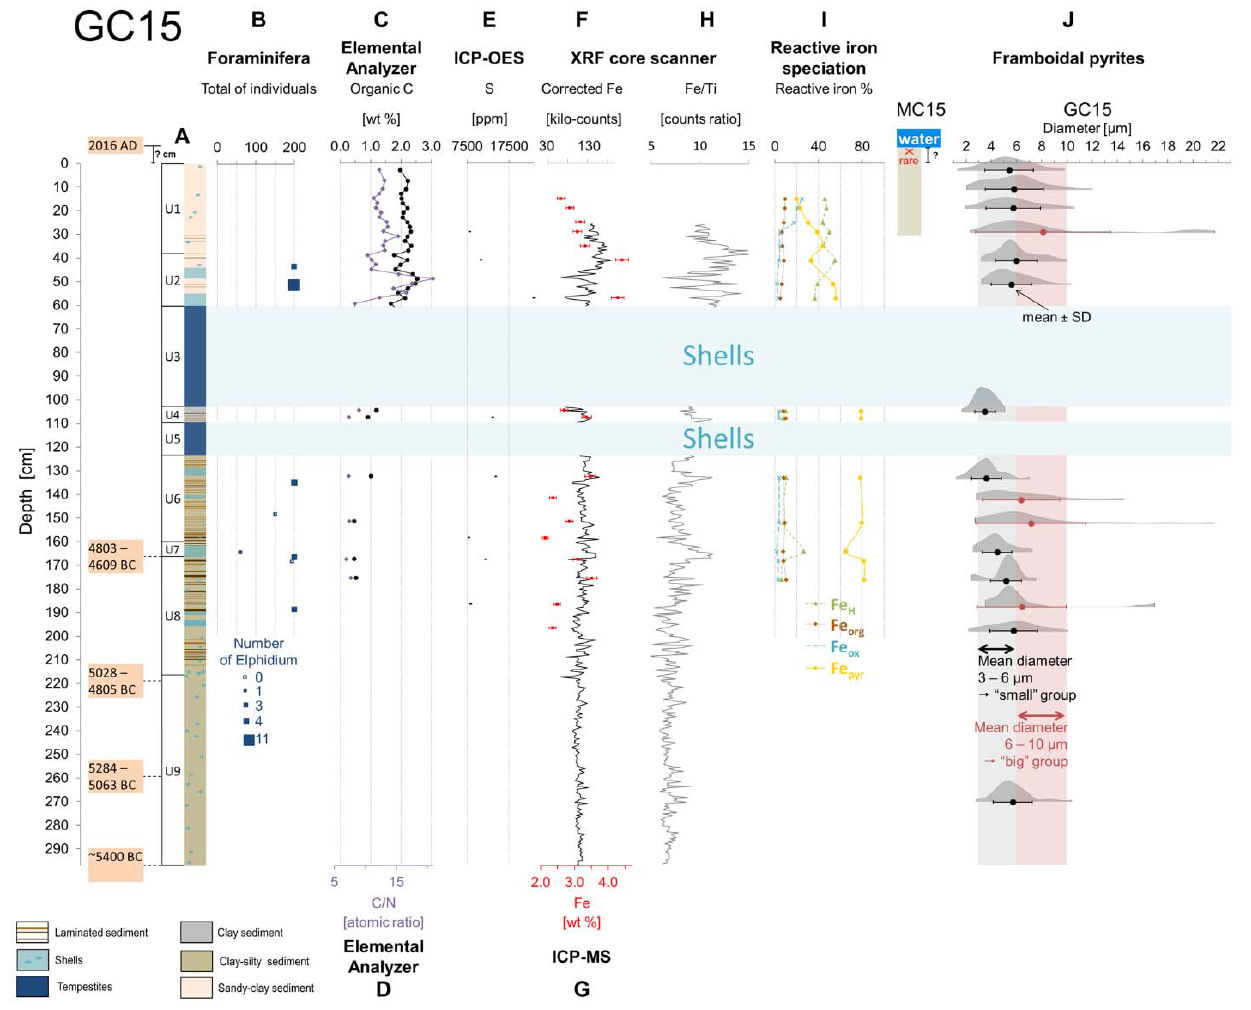
Figure 7. Results of potentially useful proxies for the GC15 core: ( A ) laminations in some parts of the core and exclusion of reworked shell layers (macroscopic observations, SCOPIX and thin sections) for other analyses; ( B ) higher number of benthic foraminifera than in GC7, including 0 to 11 Elphidium individuals per samples; ( C ) decrease with depth of organic carbon content (mean = 1.9 wt % C) and ( D ) C/N atomic ratio (elemental analyser); ( E ) relatively high total S concentration (ppm, error bar smaller than symbol) measured with ICP-OES compared to GC7; ( F ) corrected kilocounts of Fe (XRF core scanner) showing no correlation with ( G ) the total Fe concentration measured by ICP-MS (wt %, with the error bar); ( H ) Fe/Ti (XRF core scanner) variations; ( I ) increase of Fe pyr (pyrite) with depth and decrease of Fe ox (hematite and goethite) and Fe H (FeS, siderite, ferrihydrite, akaganeite and lepidocrocite), constantly low Fe org (iron bound to organic matter); ( J ) in MC15, no framboidal pyrite observed by SEM in the 0–2 cm sample just below the water-sediment interface and rare framboidal pyrite in the 2–4 cm sample; in GC15 (0 cm on the scale on the left, i.e., top of GC15, does not correspond to the water-sediment interface), framboidal pyrite size distribution showing two groups: (a) “small” group: mean diameter 3–6 µ m and narrow standard deviation (in black), (b) “big” group: mean diameter 6–10 µ m with wide standard deviation (in